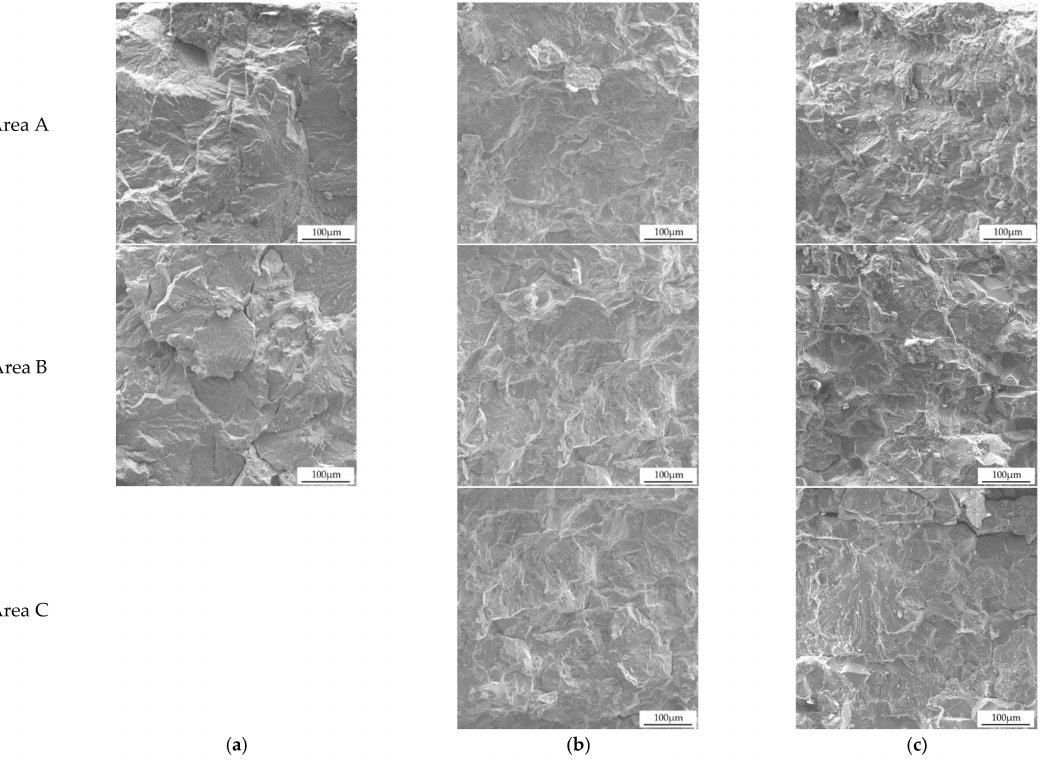
Figure 11. Cracking mode of 304LW after U-bend SCC test (SEM, × 400, 155 ◦ C, 42% MgCl 2 , top, middle, and bottom areas in Figures 10 and 11): ( a ) 304LW; ( b ) 304LW − L − NC; ( c ) 304LW − L −